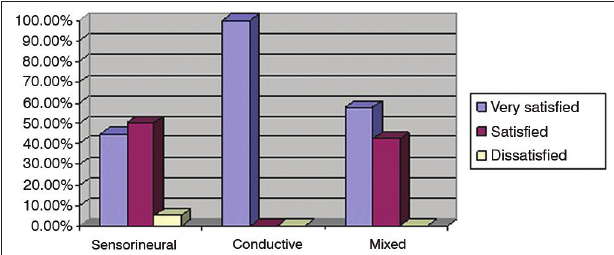
Figure 3. Percent distribution of hearing loss types per level of global satisfaction.